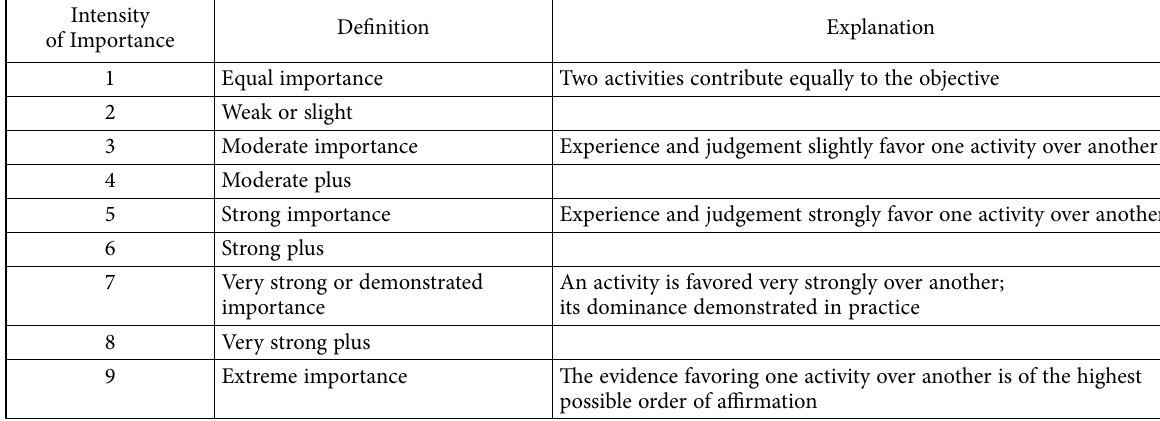
Figure 2. The network structure of the model Table 3. Fundamental scale of absolute numbers (Saaty, 2008)